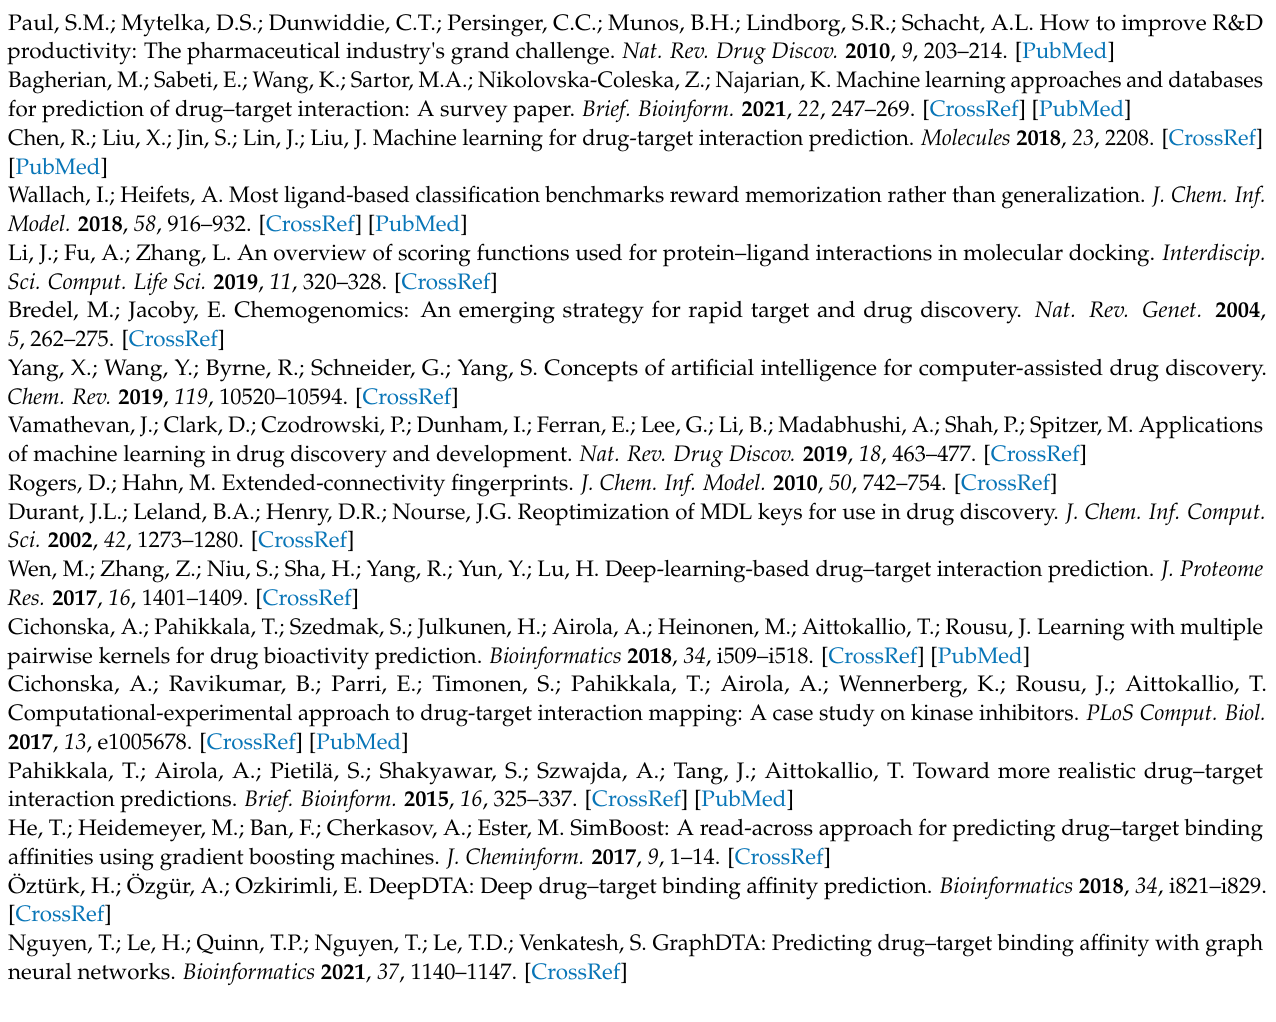
Figure S8: Performance comparisons of GraphATT-DTA and baseline models on the difference between the affinity of wild and mutant proteins. (a) FLT3 (b)